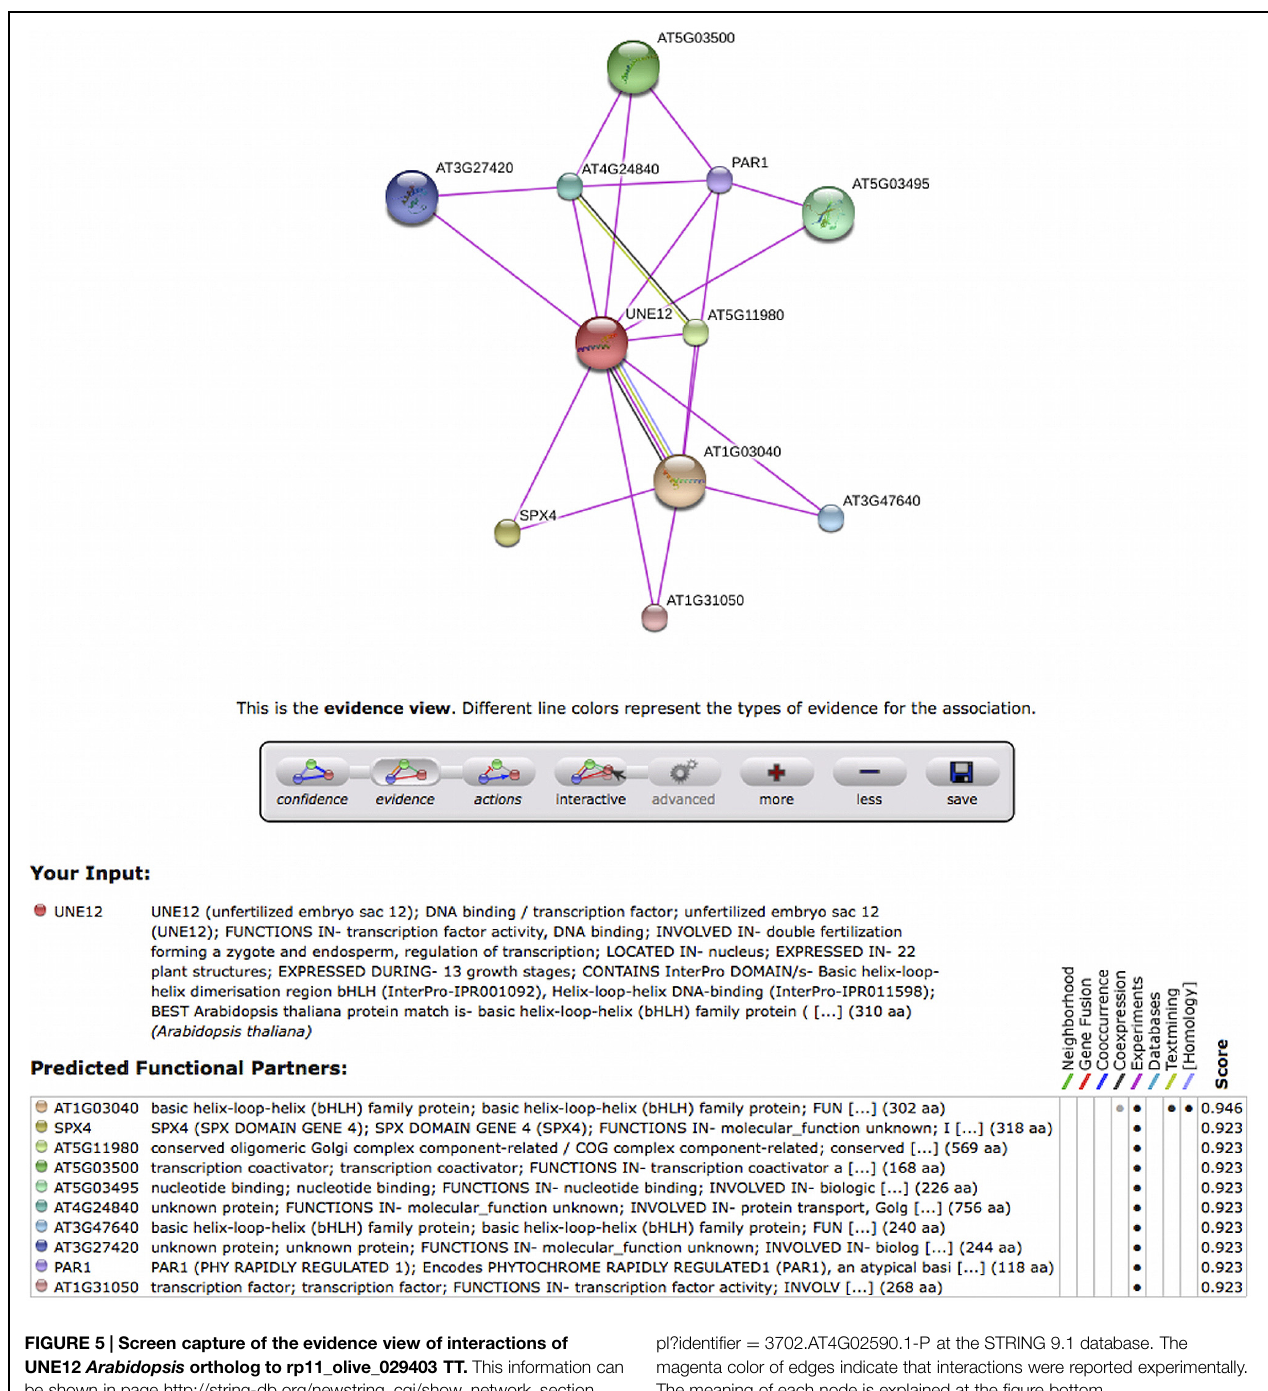
pl?identifier = 3702.AT4G02590.1-P at the STRING 9.1 database. The magenta color of edges indicate that interactions were reported experimentally. The meaning of each node is explained at the figure